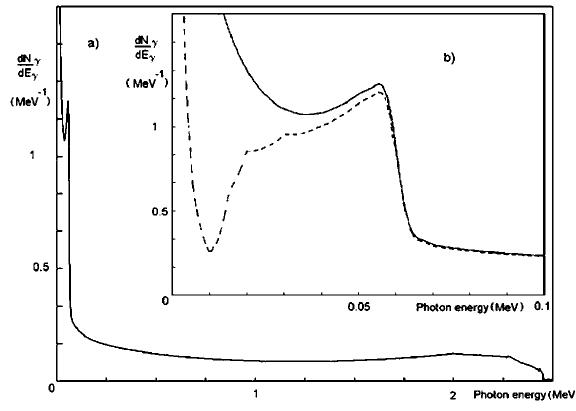
FIG. 6. The expected photon spectrum for 800 MeV positrons in the range 0–2.5 MeV (a) and 0–0.1 MeV (b). The dashed curve is the photon spectrum, where the absorption process of photons in the body of the undulator is taken into account. The curves are normalized on one positron passing through the undulator within the channeling